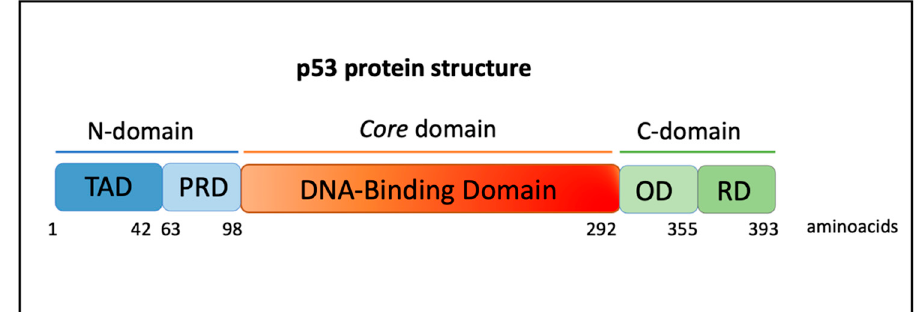
Figure 1. Protein domains of p53. Human p53 protein has 393 aminoacidic residues and is composed of a transactivation domain (TAD), proline-rich domain (PRD), DNA-binding domain (DBD), tetramerization or oligomerization domain (OD), and a C-terminal regulatory domain (RD).